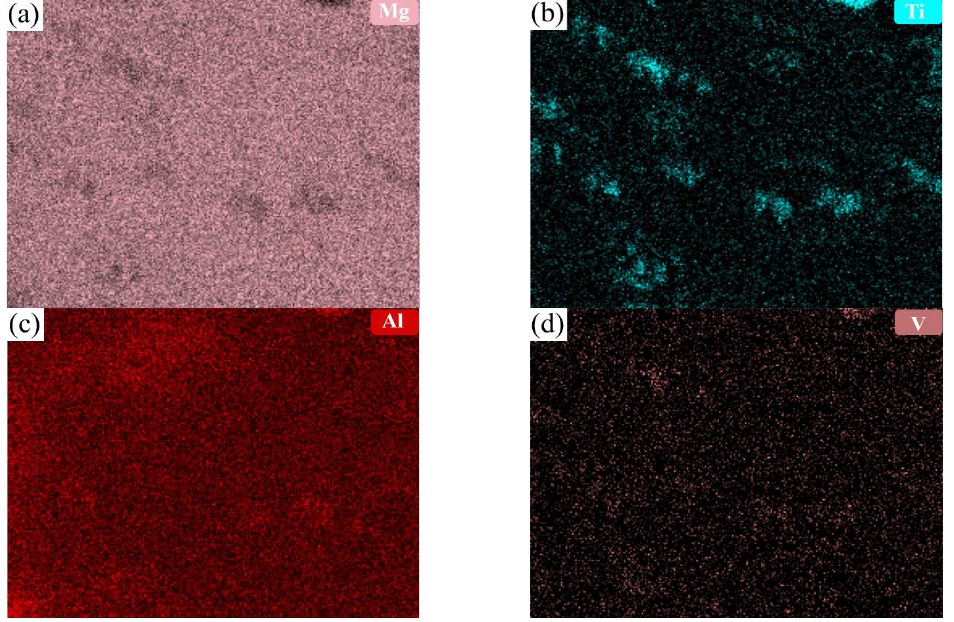
Figure 2. Low-magnification SEM ( a ) and high-magnification SEM ( b ) of 1 wt.%TC4 nanoparticles ’ dispersion on the surface of magnesium powder particles.